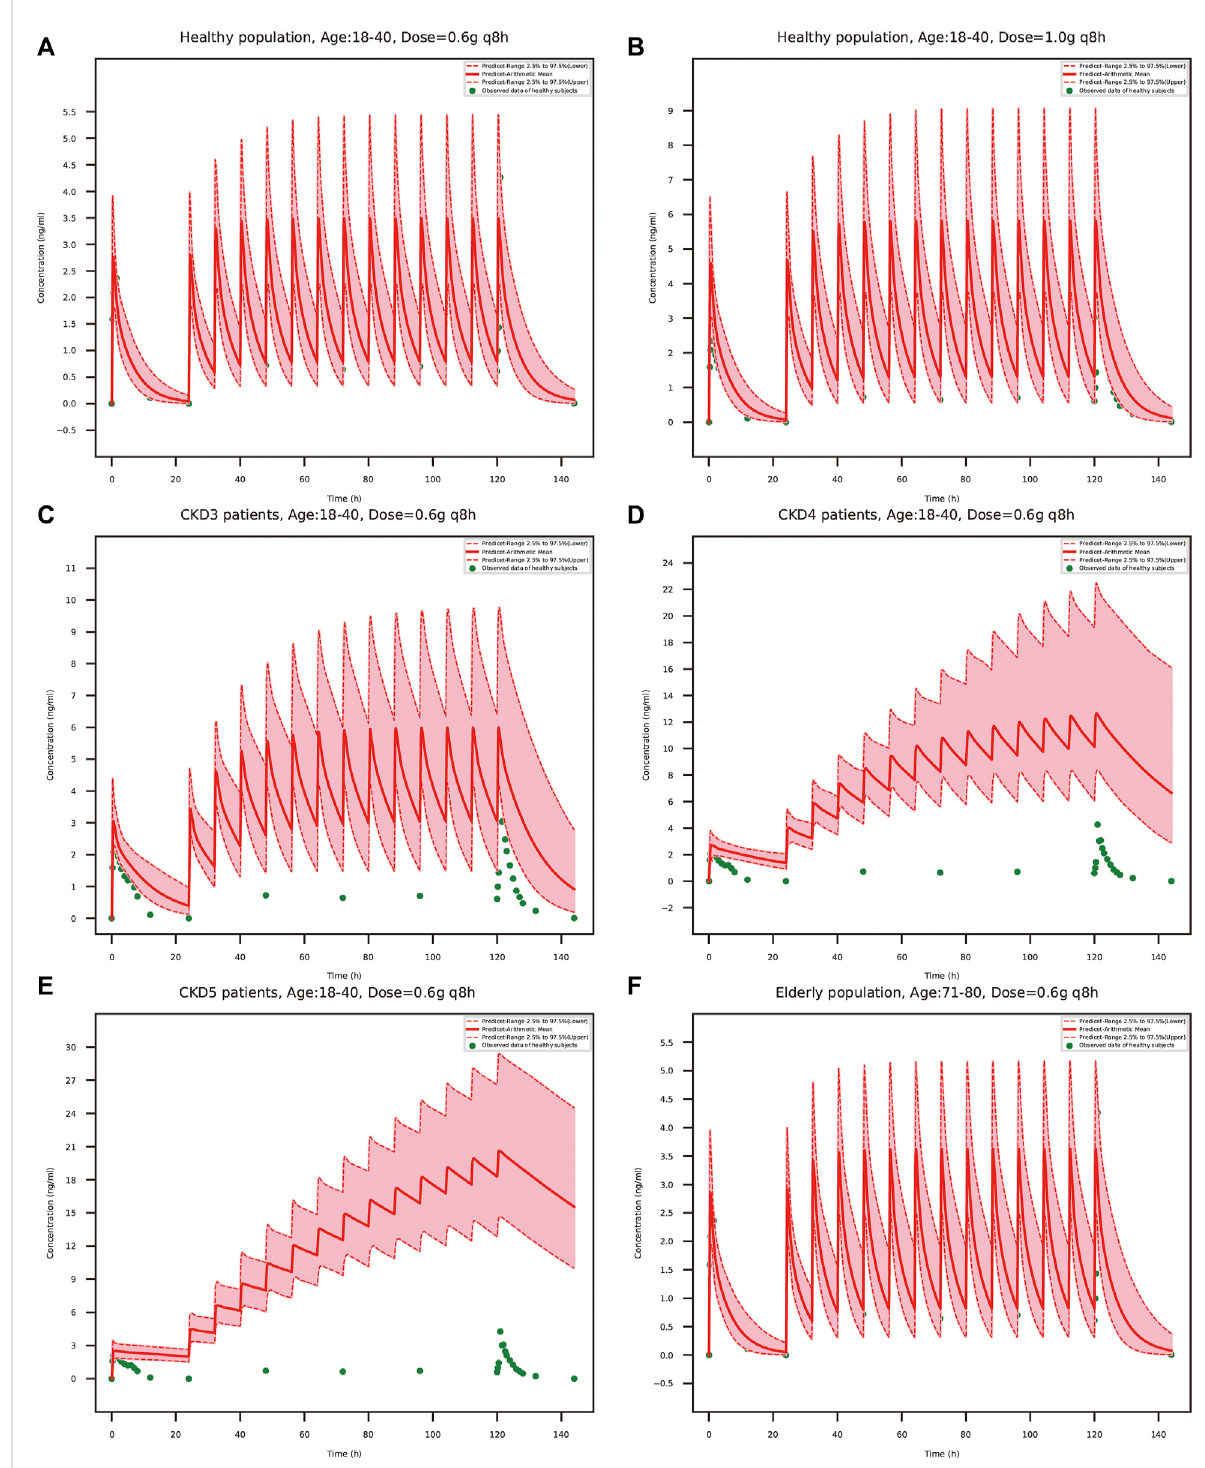
FIGURE 8 PBPK model-simulated schaftoside plasma concentration-time pro fi les in healthy population (18 – 40 years) at the TFDS regular dosage (A) : 0.6 gq8 h)orahigherdosage (B) :1 gq8 h),renallyimpairedpatientswithCKD stage3 (C) ,GFR=60 ml/min/1.73 m 2 ),CKD stage4 (D) ,GFR=30 ml/ min/1.73 m 2 ), CKD stage5 (E) , GFR = 15 ml/min/1.73 m 2 ), and elderly population (F) , 71 – 80 years). Simulated data included the mean values, 97.5th percentile and 2.5th percentile concentration range. The green solid circles represent mean observed data obtained from the healthy volunteers in the present clinical